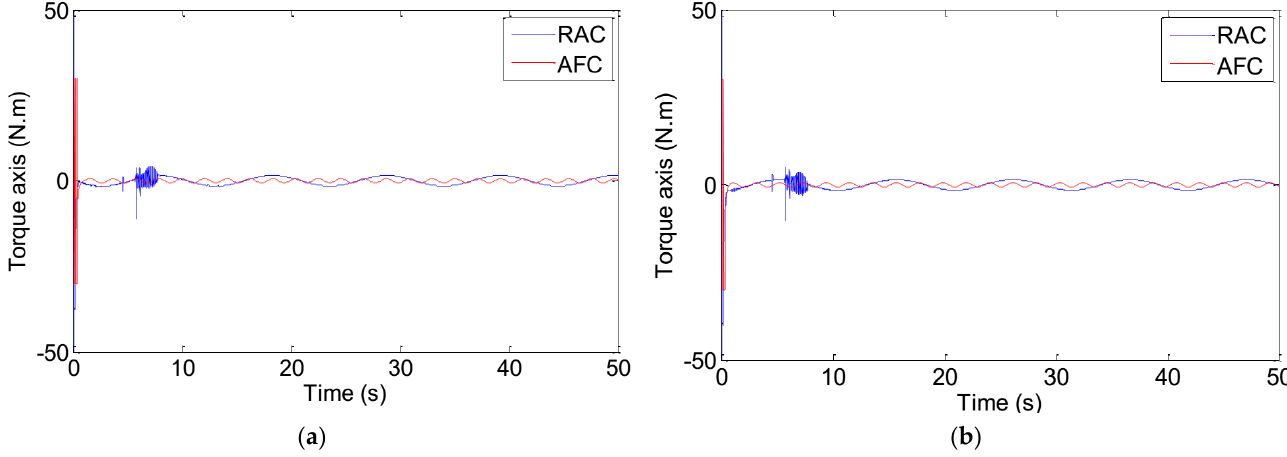
Figure 7. ( a ) Right wheel control signal and ( b ) Left wheel control signal.